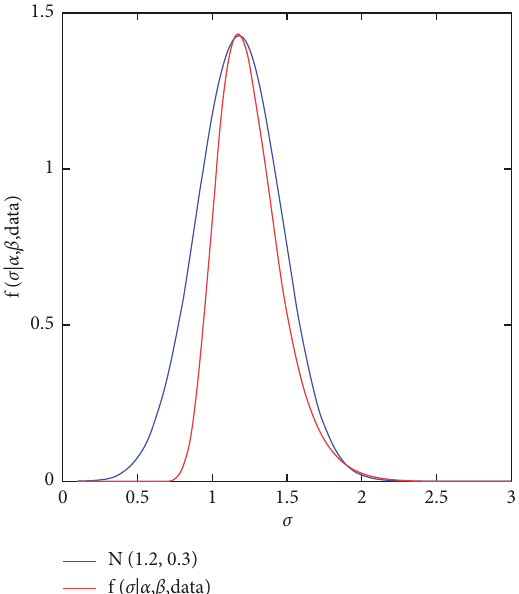
Figure 3: Proposal and posterior density functions of the scale parameter.